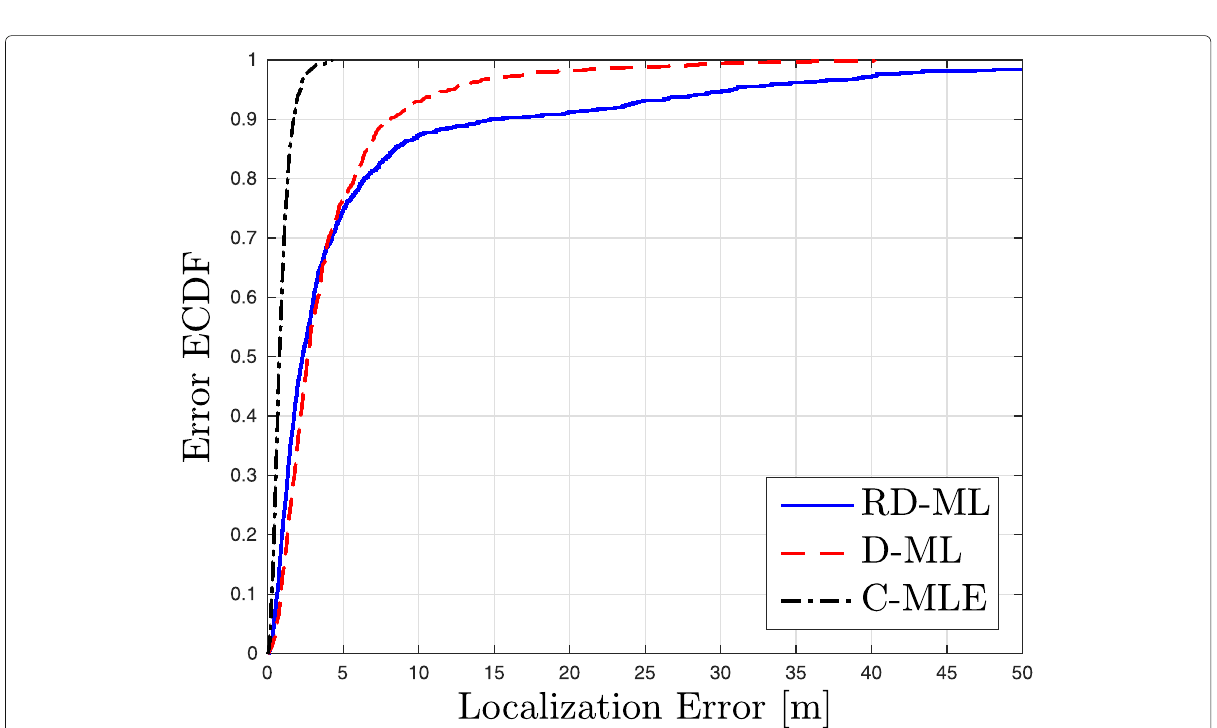
Fig. 4 All LoS links with white Gaussian noise. Fully connected networks, N a = 11, N u =